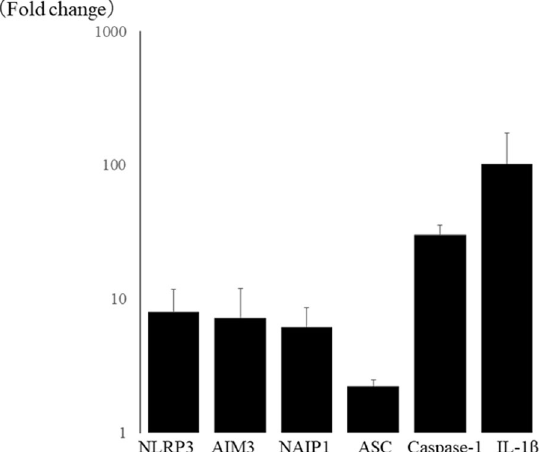
Figure 1. Inflammasome-related molecules are up-regulated in corneal alkali burn using PCR array. Among NLR family, NLRP3 (8.0 ± 3.9 fold) is most up-regulated, and AIM(absent in melanoma)3 (7.2 ± 4.8 fold) and NAIP1 (neuronal apoptosis inhibitory protein 1) (6.2 ± 2.5 fold) are also up-regulated. Other inflammasome components, IL-1 β (102.4 ± 71.1 fold), caspase-1 (30.1 ± 5.4 fold), and apoptosis-associated speck-like